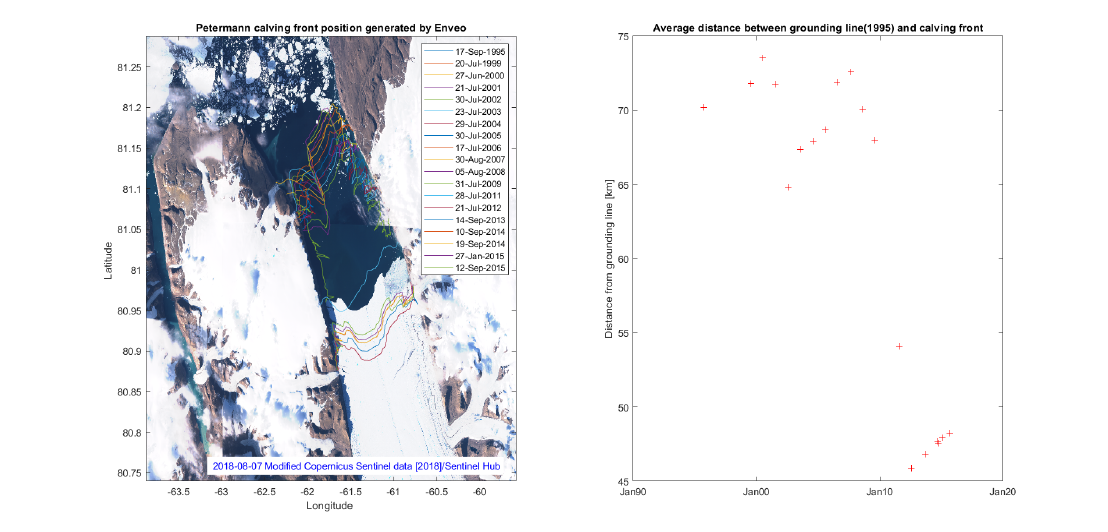
Figure 9. ( left ) Petermann glacier calving front location between 1995 and 2015. ( right ) Average distance between a reference grounding line of 1995 and the calving front of Petermann